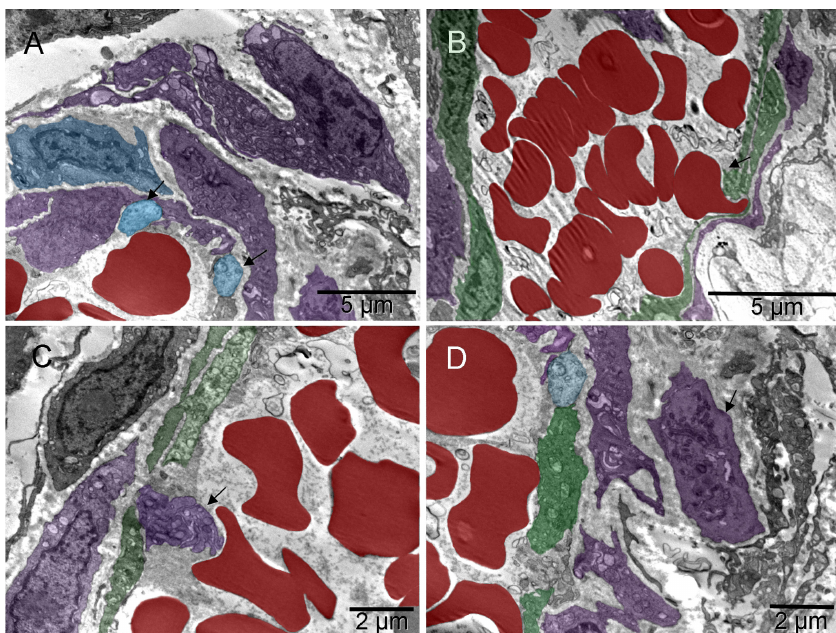
Figure S12. Ongoing structural rearrangements in the less advanced region of the forming artery (I). The images were from a section parallel to the one shown in Figure S8, i.e., from another region of the same vessel. Arrows point to two chromaffin cells (blue) in [ A ]; erythrosome (red), platelets (purple) and maturing platelets “ante portem” i.e. facing the opening in the endothelium (green), are shown in [ B, C & D ], respectively.